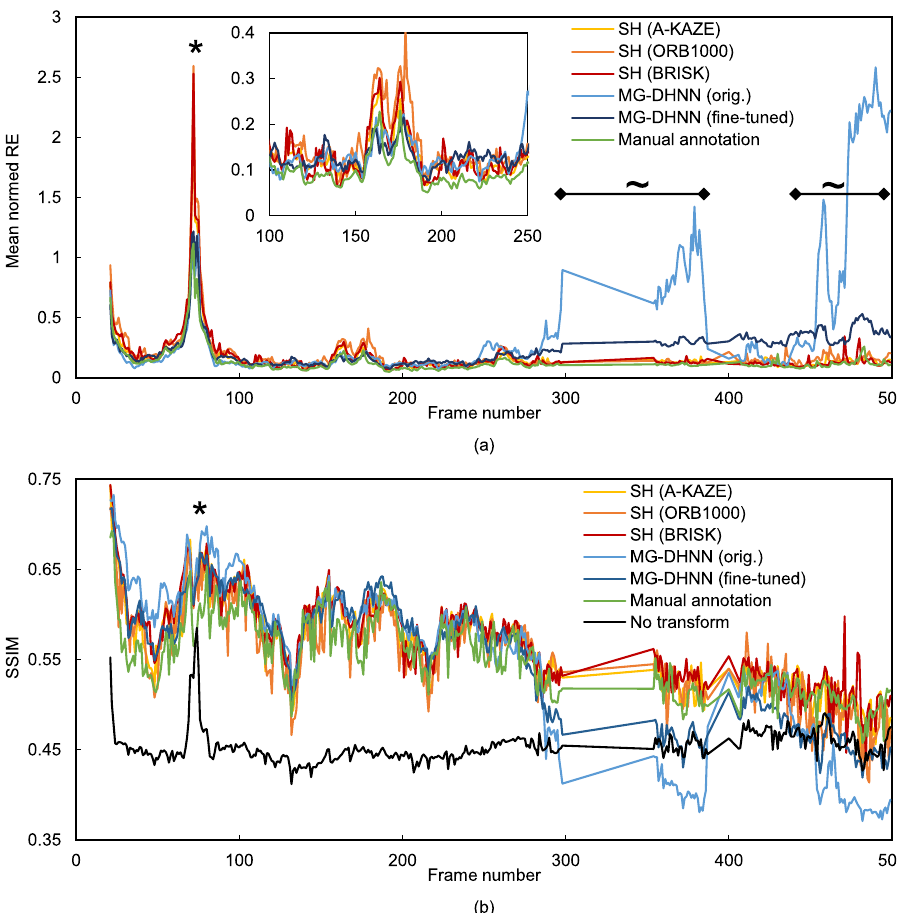
Figure 5. ( a ) Mean normalized RE and ( b ) SSIM of start frame 20 and all consecutive frames with more than 15 corresponding manual annotations. Mean normalized RE and SSIM are shown for single homography estimation (A-KAZE, ORB1000, BRISK, and manual annotation) and MG-DHNN (original and fine-tuned). Additionally, SSIM is shown without any applied transformation. Frames labeled with * are very similar to the start frame and show a high SSIM without transformation. The mean normalized RE shows higher values for these frames because of the very small moved distances of the manual annotations. However, the SSIM of the transformed frames is still higher than without transformation. Frames labeled with ~ include tissue deformations caused by surgical instruments. From frame number 390 on, large parts of the image are partially occluded by two instruments in the field of